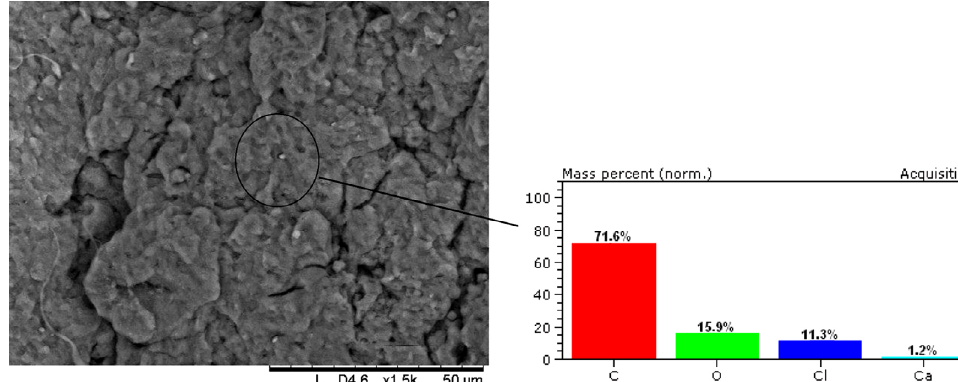
Figure 4. Micrography and EDS of formulation F3-5N.